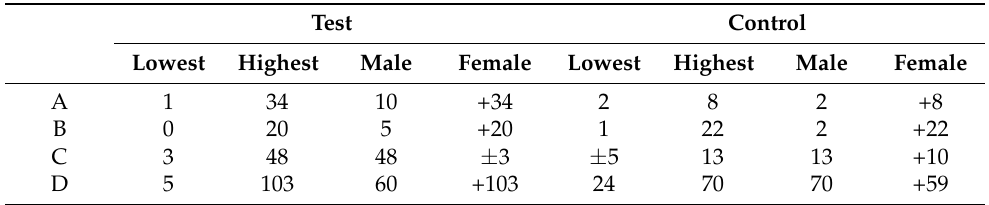
Table 4. Comparative analysis of exercise performance data between experimental group and control